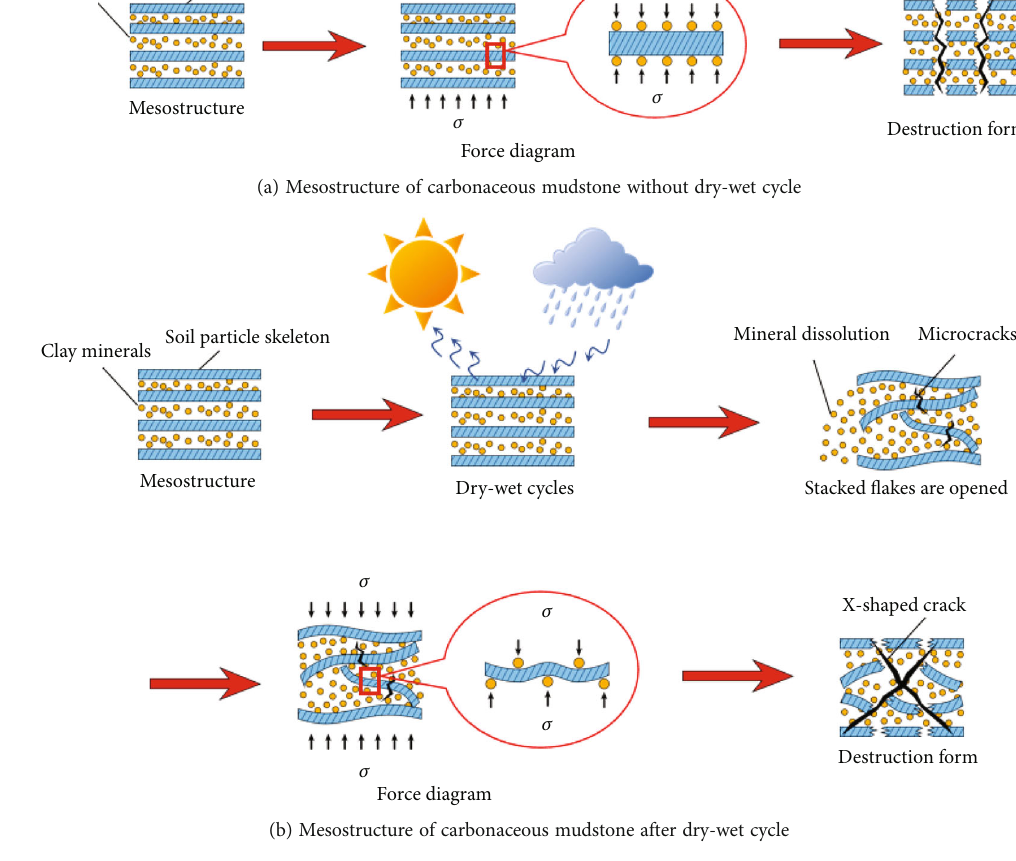
Figure 7: Mesostructure of carbonaceous